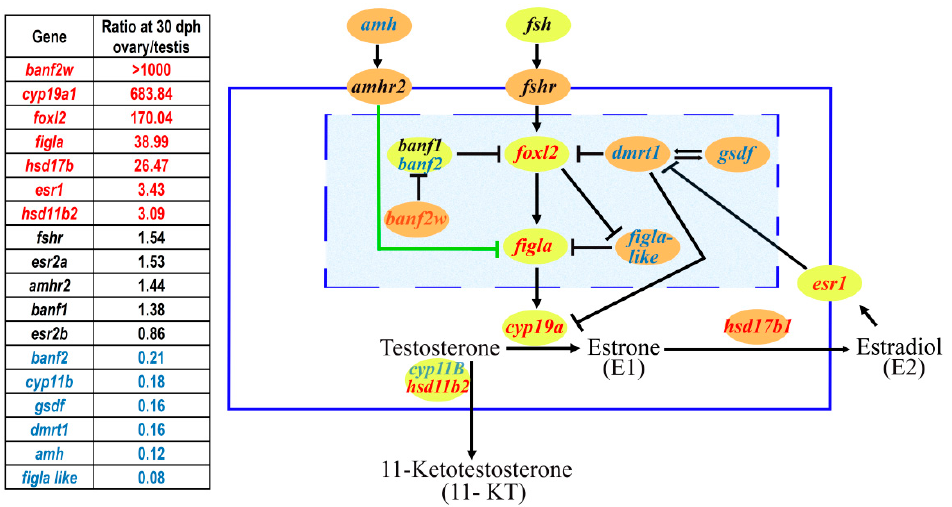
Figure 1. A proposed schematic model of the sex determination (SD) pathway in tilapia, based on current knowledge of master key regulators (MKRs) of SD and their effects on estrogen/androgen (E2/11-KT) equilibrium. Identifications of MKRs of SD from different fish species are colored orange and other factors are yellow. The table on the left indicates the RPKM (Reads Per Kilobase of transcript per Million mapped reads) of ovary/testis expression-values of genes in Oreochromis aureus at 30 days post hatching (dph) (BioProject accession number: PRJNA609616). Genes with male and female biased expression values are colored in blue and red, respectively. Arrows ( ↓) represent up- regulation/production, whereas blocked arrows ( ⊥) mark down-regulation/production. The green lines represent the SMAD signaling pathway. MKRs of SD without a clear function or relevance to SD in tilapia are not displayed ( gdf6 , sdY, dmy, sox3 , bmpr1bby and zkY ) in the figure. However, gdf6 and bmpr1bby are members of the TGF-beta superfamily and may affect SMAD signaling, and thus may have similar functions to those of amh and gsdf . Other undepicted SD MKRs are the sdY gene that interacts with foxl2 in Salmonids, sox3 that regulates gsdf, and zkY with unknown functions. The blue solid line represents the cell membrane.